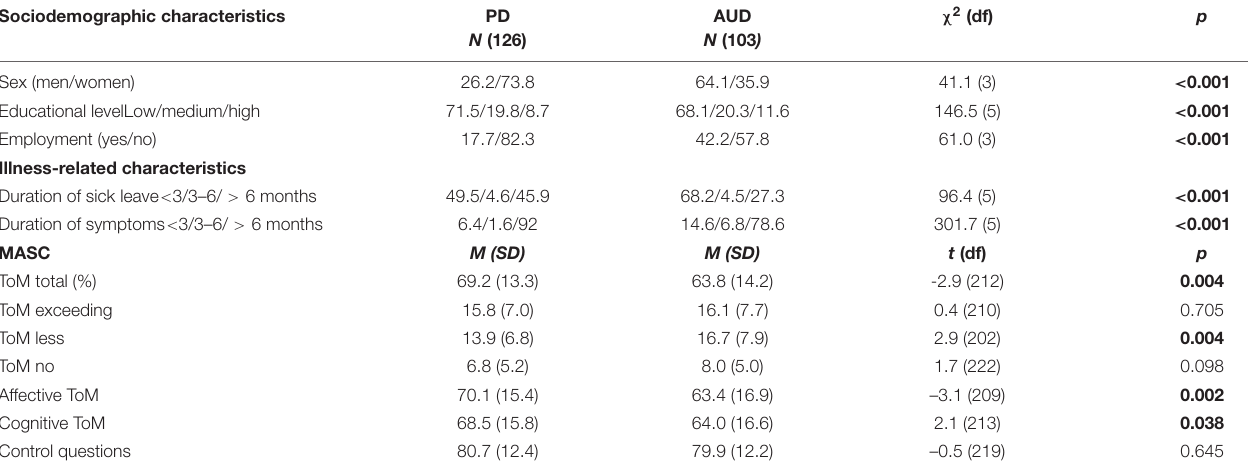
TABLE 1 | Sociodemographic-, illness-related characteristic and MASC test results (%) *. Sociodemographic characteristics